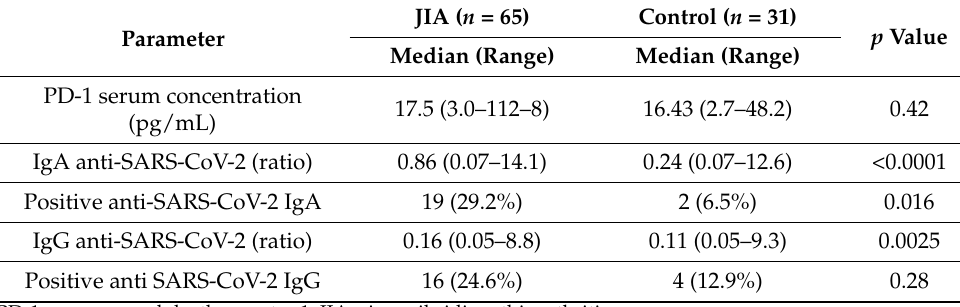
Table 2. Immunological characteristics of the